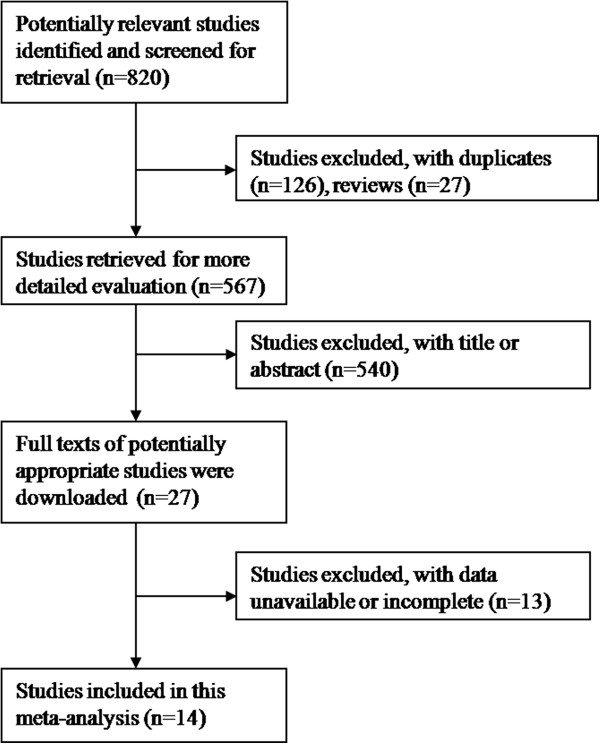
The process of data selection.